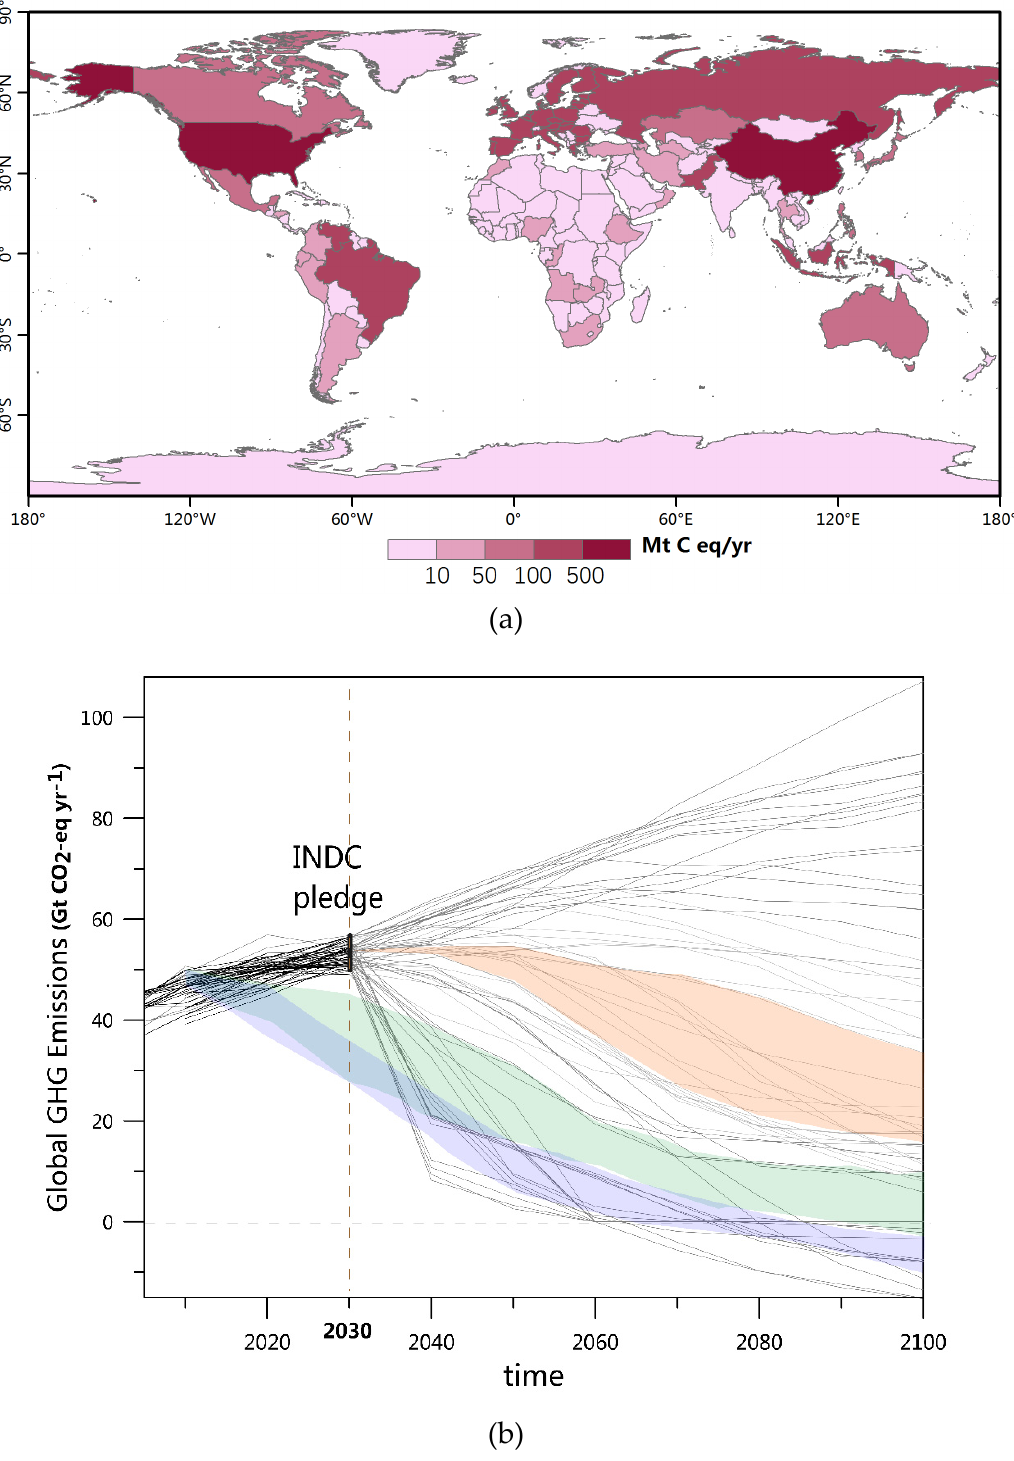
Figure 1. Global greenhouse gas (GHG) emissions of the Intended Nationally Determined Contributions (INDC) scenarios. ( a ) Emission reductions of countries with unconditional INDC pledges in 2030 (relative to the baseline development scenarios). ( b ) Global GHG emission pathways; grey lines indicate INDC pathways until the end of this century based on simulations of future emissions from 28 socioeconomic models. The different colours indicate ranges of INDC ‘continued action’ (orange), 2.0 °C (green), and 1.5 °C (blue) scenarios. In addition, the 2.0 °C/1.5 °C temperature target scenarios consistent with the Paris Agreement were also analyzed in this study. The 2.0 °C/1.5 °C target scenarios are based on the Fifth Assessment